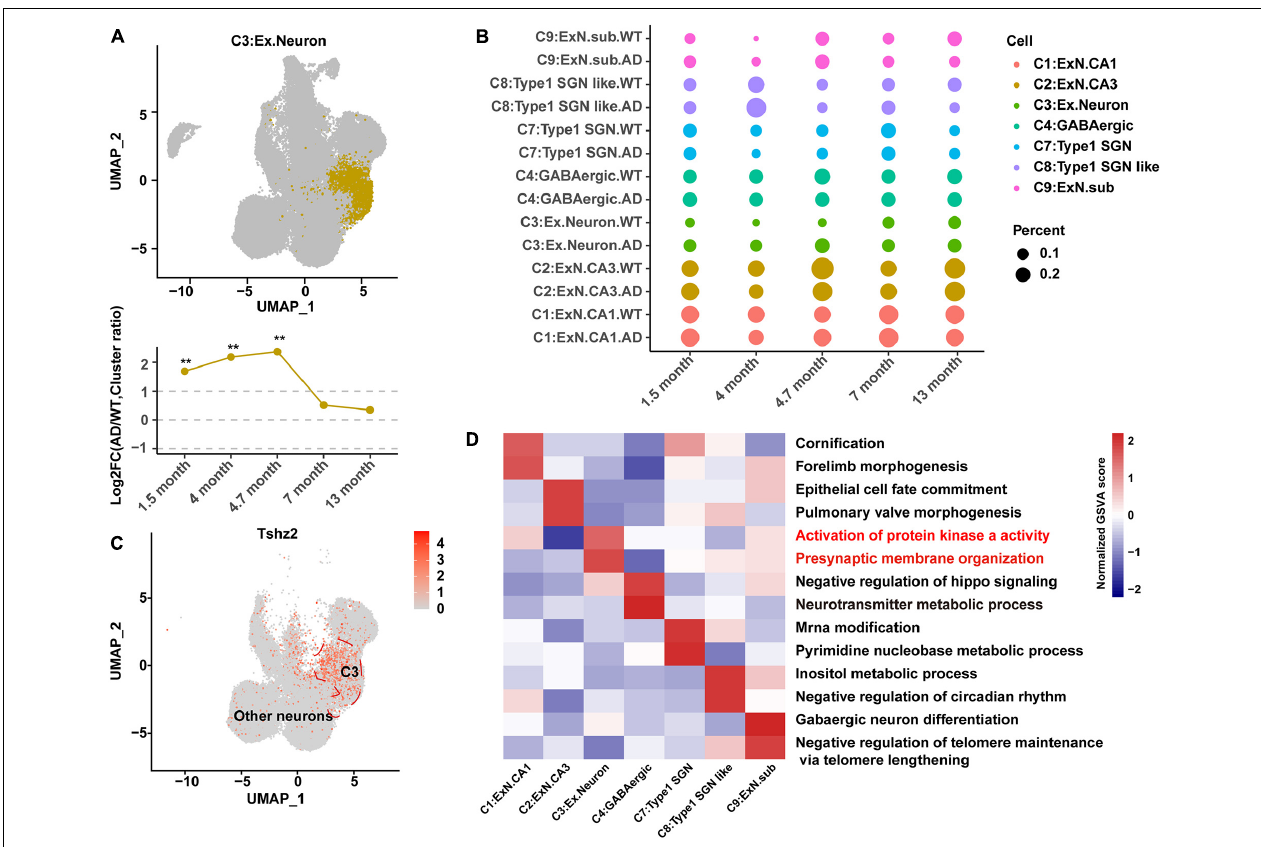
FIGURE 2 | Identification and characteristics of C3:Ex.Neuron as an AD-associated neuronal population. (A) Uniform Manifold Approximation and Projection (UMAP) plot showing the distribution of excitatory neurons in the hippocampus. The bottom graph shows the ratio changes in AD excitatory neurons compared to those in WT neurons at 1.5, 4, 4.7, 7, and 13 months. G-test, ** p < 0.001. (B) Dot plot showing the ratio of neuron cell groups between AD and WT mice. The dot size represents the percentage of cells. (C) UMAP plot showing the expression of specific genes in excitatory neurons compared to that in other neuron cell groups of